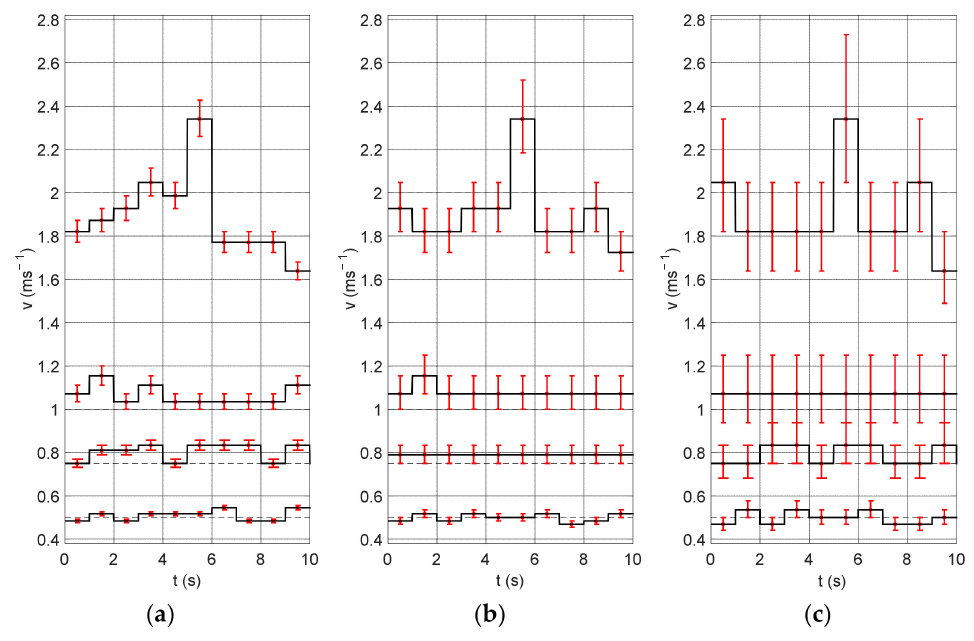
Figure 7. Cumulative results of the experiment for different sampling frequencies: ( a ) 10 kHz, ( b ) 5 kHz and ( c ) 2.5